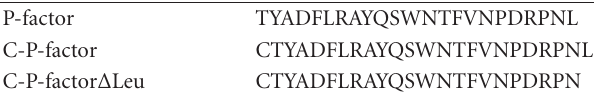
Table 1: List of peptides used in this